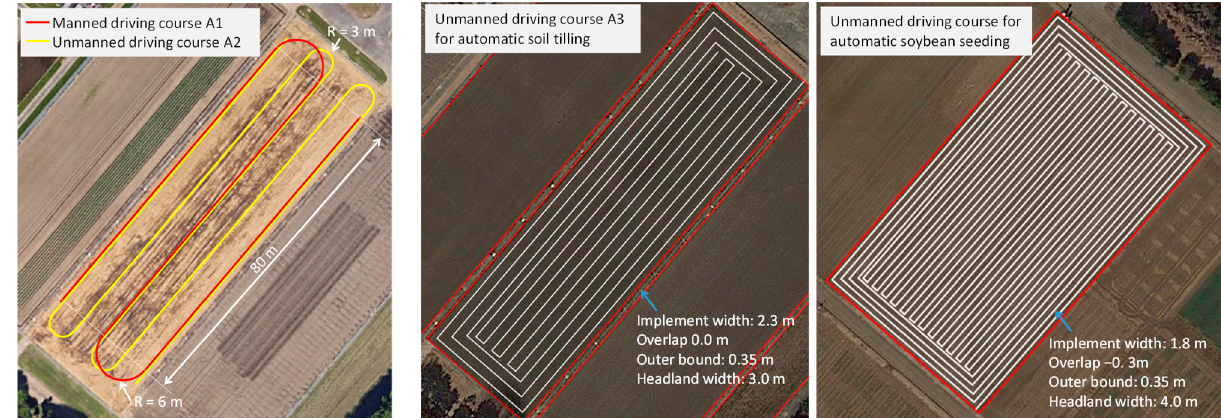
Figure 3. Manned and unmanned driving courses within agricultural fields.